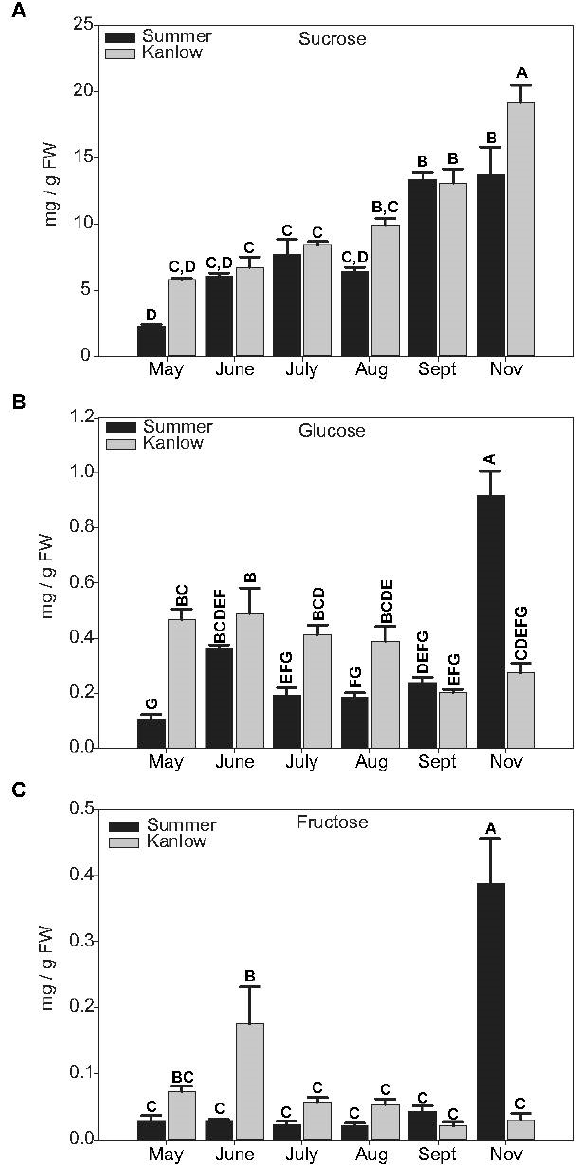
Figure 2. Sugar levels in rhizomes at each sampling date. ( A ) Sucrose. ( B ) Glucose. ( C ) Fructose. In all panels, black bars indicate Summer, and grey bars indicate Kanlow rhizomes. Letters over each bar denote statistical significance. Error bars represent standard error.